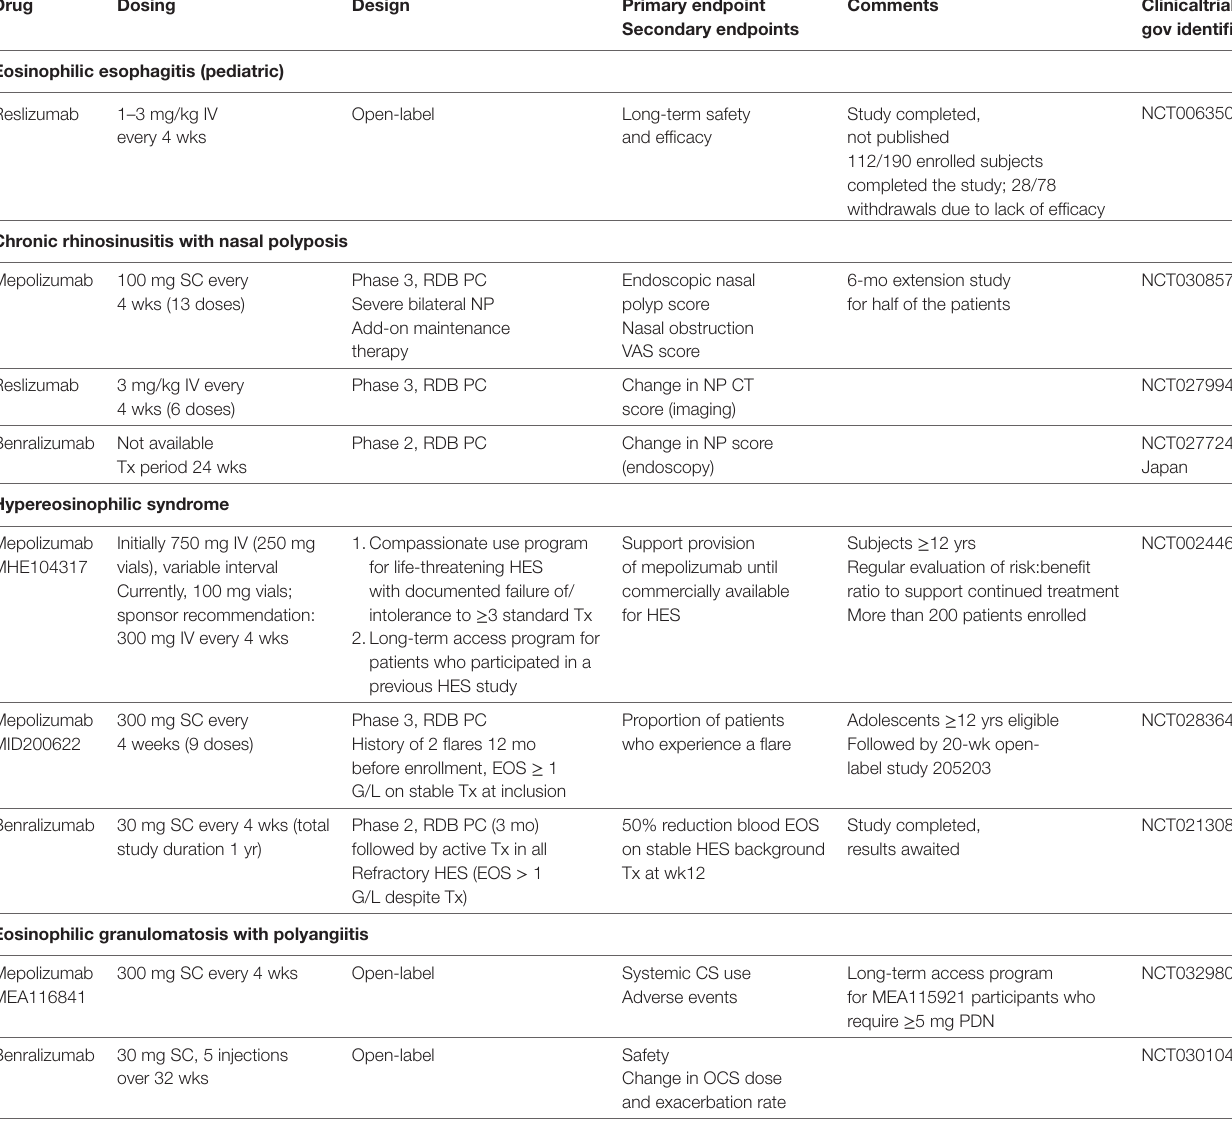
TABLe 5 | Ongoing and planned clinical trials in eosinophilic disorders other than asthma using IL-5 targeted